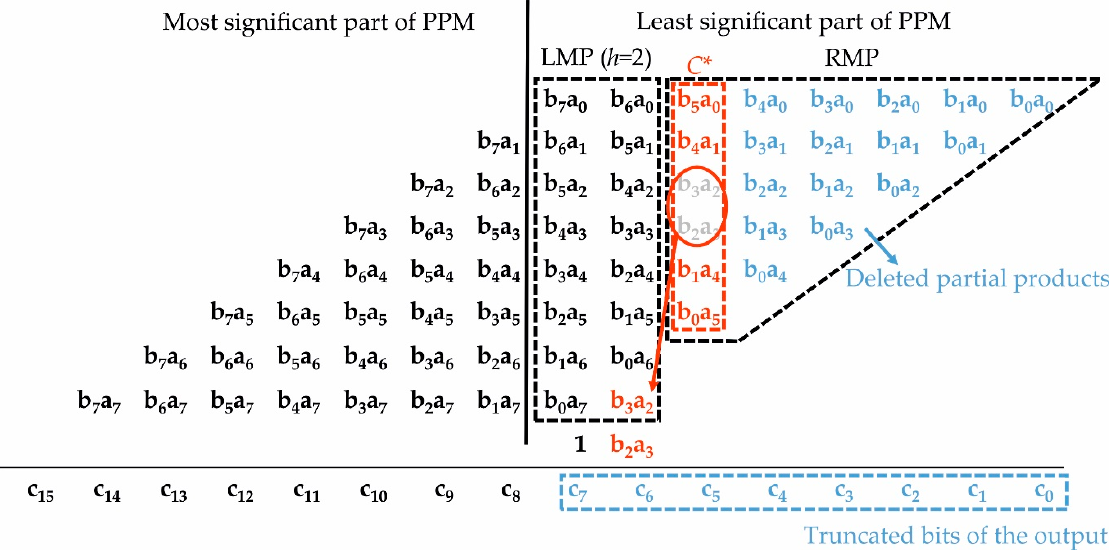
Figure 5. Partial product matrix of the unsigned fixed-width multiplier proposed in [34]. In the figure, it is chosen h = 2.